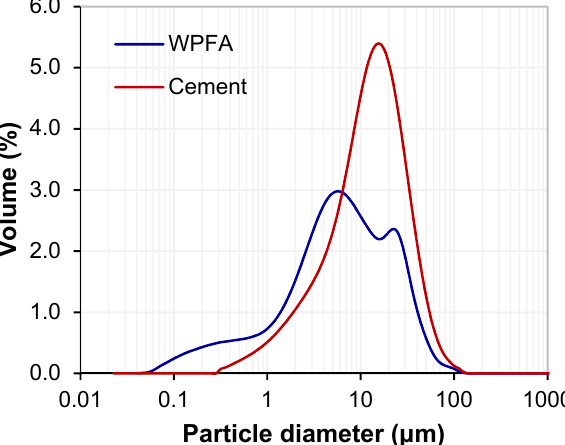
0.01.02.03.04.05.06.0